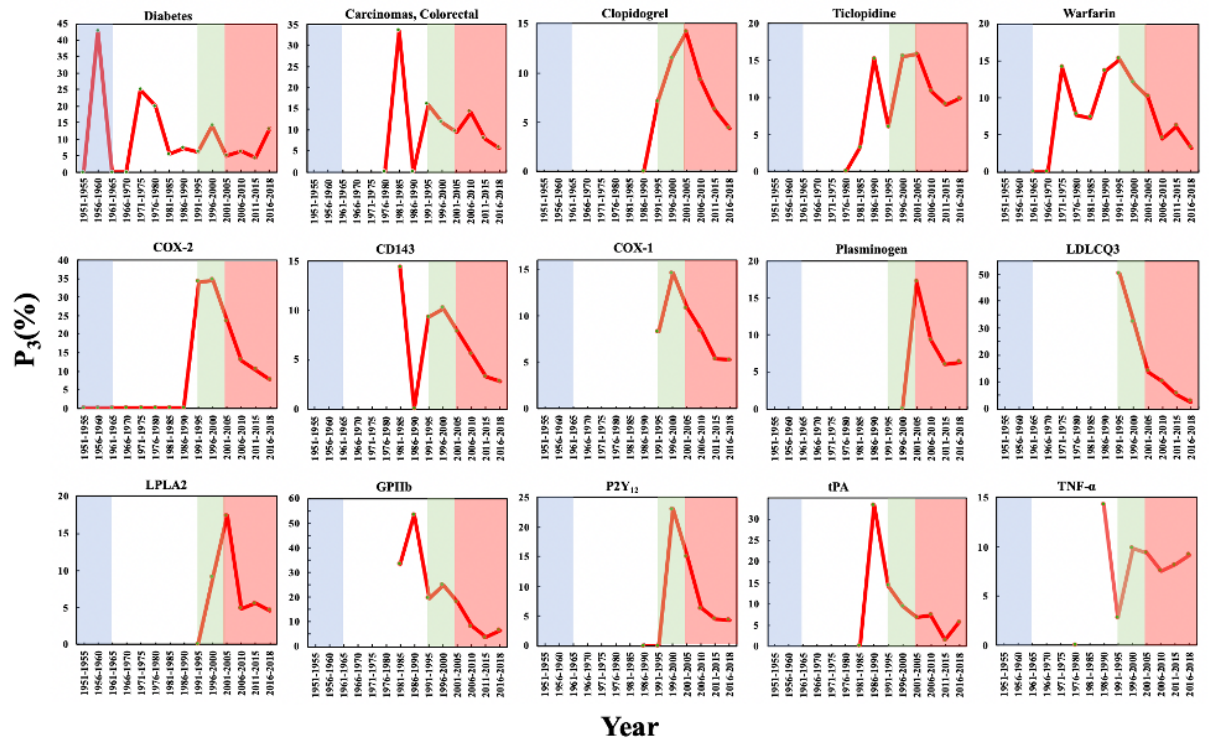
Figure 10. The Prestige Index (P 3 ) of the biomedical entities on repurposing aspirin for other diseases over time. The background colors show the 4 phases of aspirin research.